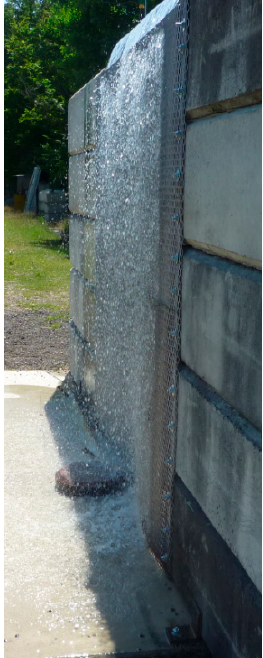
Figure 8. First grid equipped with a pool fountain.